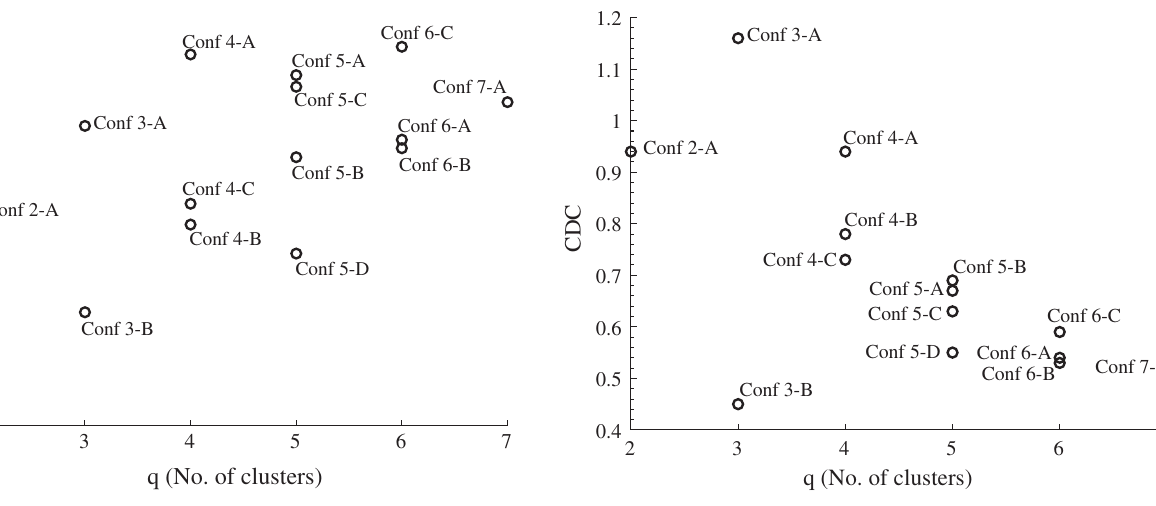
FIG. 10. CDC values for the different cluster configurations obtained by means of H -CLA